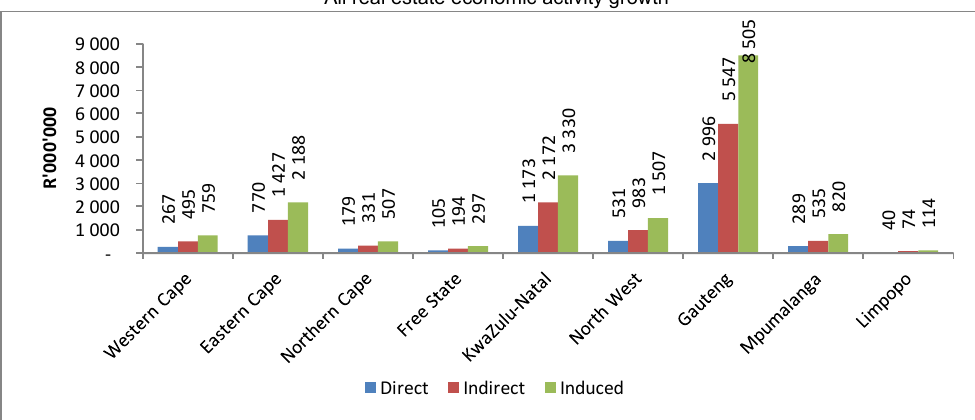
All real estate economic activity